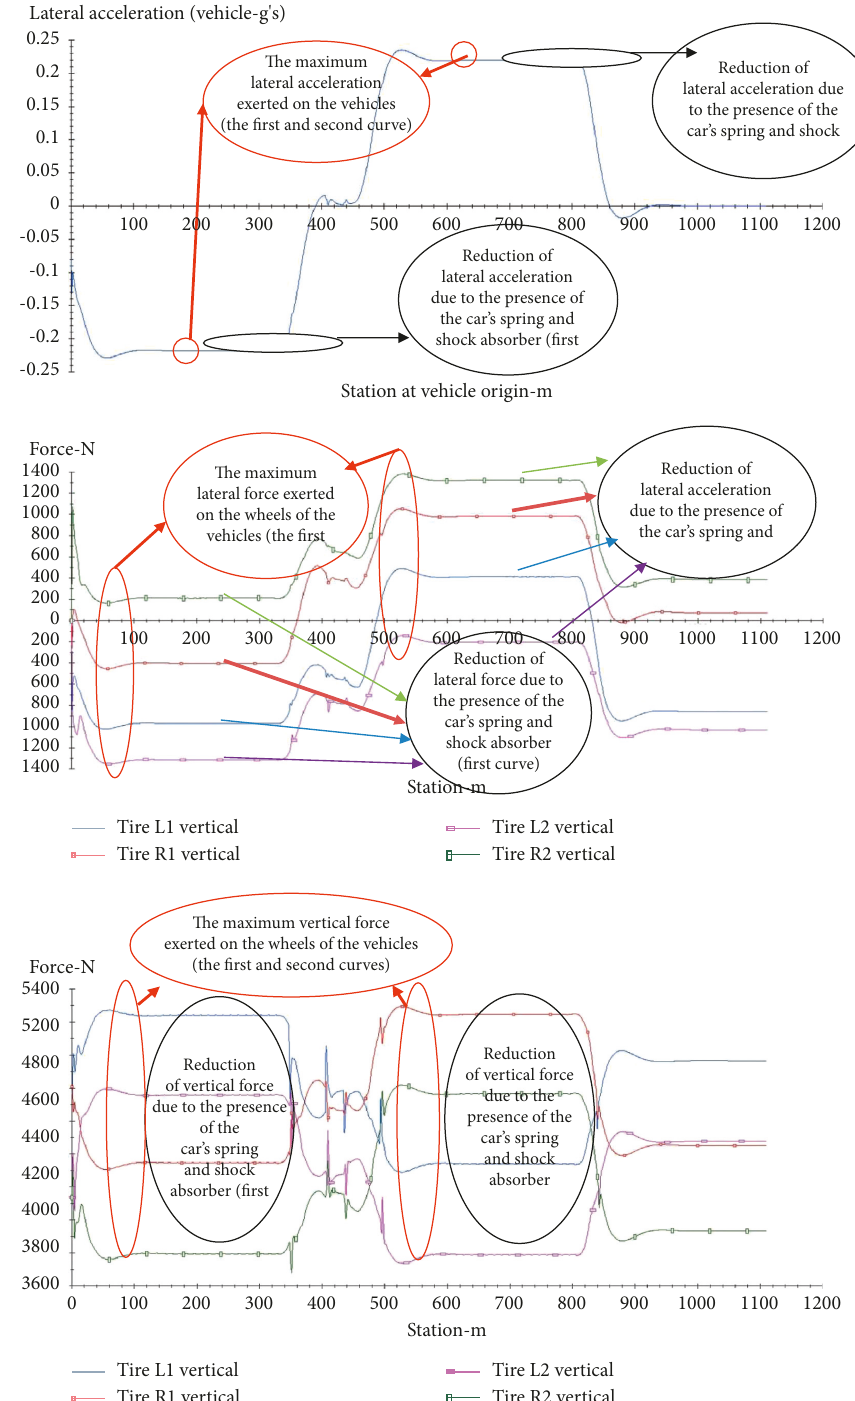
Figure 1: Simulation output includes lateral acceleration, lateral force, and vertical